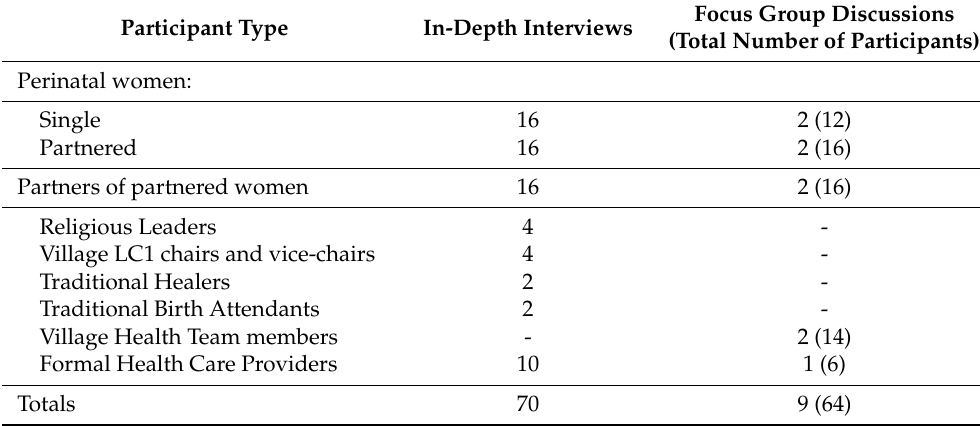
Table 1. Participant types and data collection